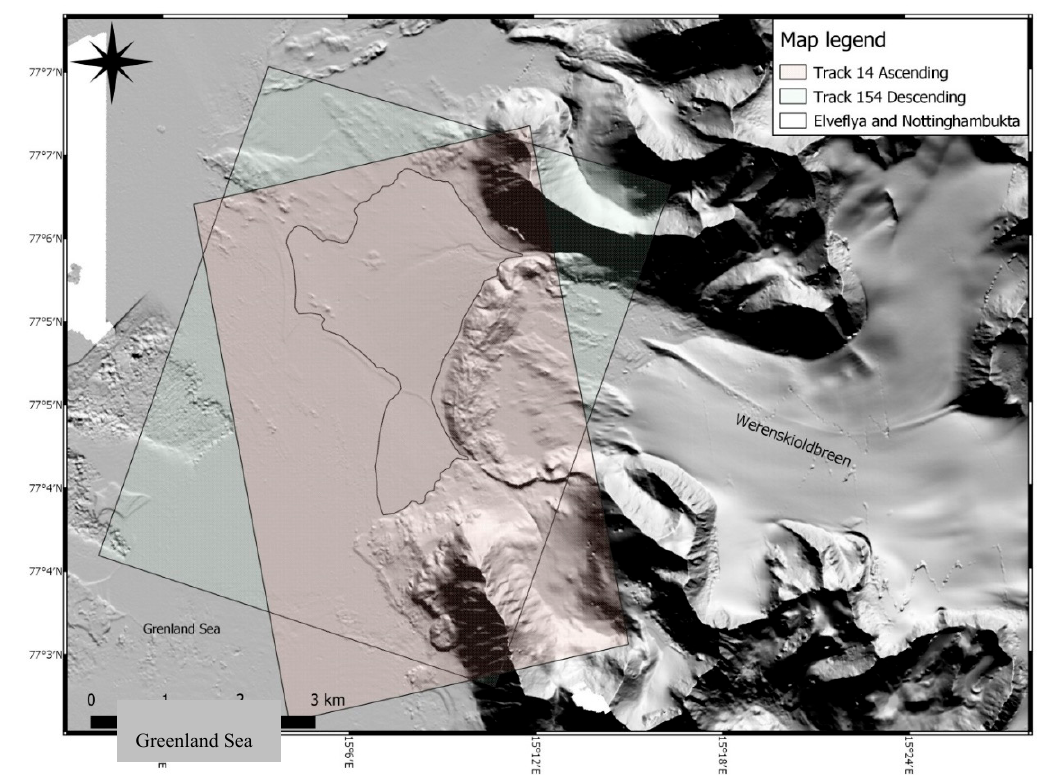
Figure A1. Extent of the processed area of Sentinel 1A/1B Tracks 14 (ascending) and 154 (descending). Only the SAR range used to calculate the LOS displacements is shown in the figure. In background Digital Elevation Model (DEM) from ArcticDEM https://www.pgc.umn.edu/data/arcticdem/.